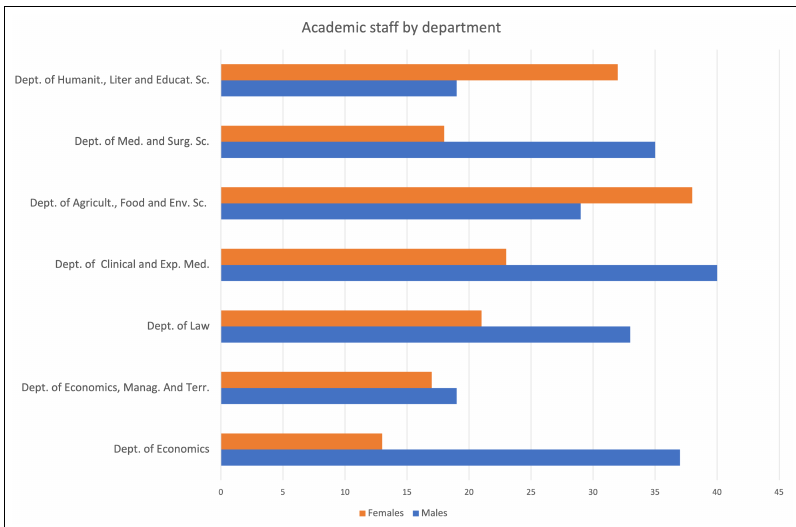
Figure 2. Composition of academic staff.